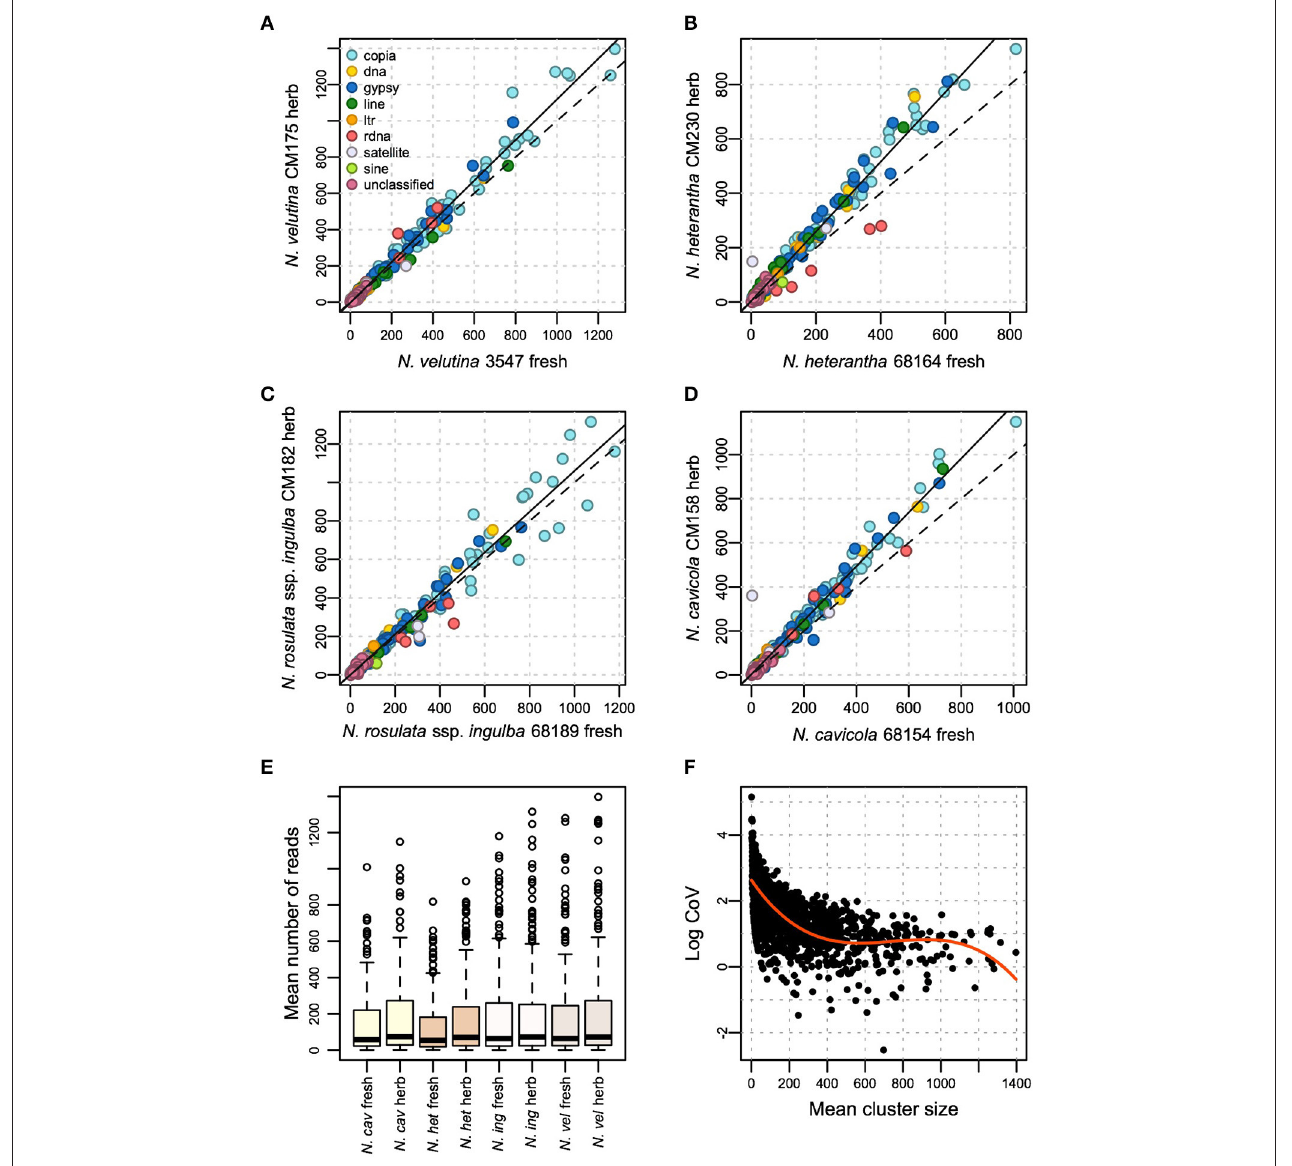
FIGURE 2 | Scatter plots (A-D) showing the cluster size (number of reads) relationship between pairs of taxa (herbarium vs. fresh material), for 232 clusters (each above 0.01% of the genome). Best-fit (solid) and 1:1 (dashed) lines are shown. Dots are colored based on repeat annotation (legend inset). Species pairs as follows, with Pearson’s correlation coefficients and adjusted R 2 values, respectively: (A) N. velutina , r = 0.990, R 2 = 0.980; (B) N. heterantha , r = 0.983, R 2 = 0.986; (C) N. rosulata subsp. ingulba , r = 0.979, R 2 = 0.958; (D) N. cavicola, r = 0.985, R 2 = 0.969. (E) Mean number of reads in repeat clusters per species and sample type, showing higher numbers in herbarium samples. (F) Polynomial regression plot of mean cluster size (number of reads) and log CoV (coefficient of variation), showing increased CoV at lower cluster sizes ( Table S4